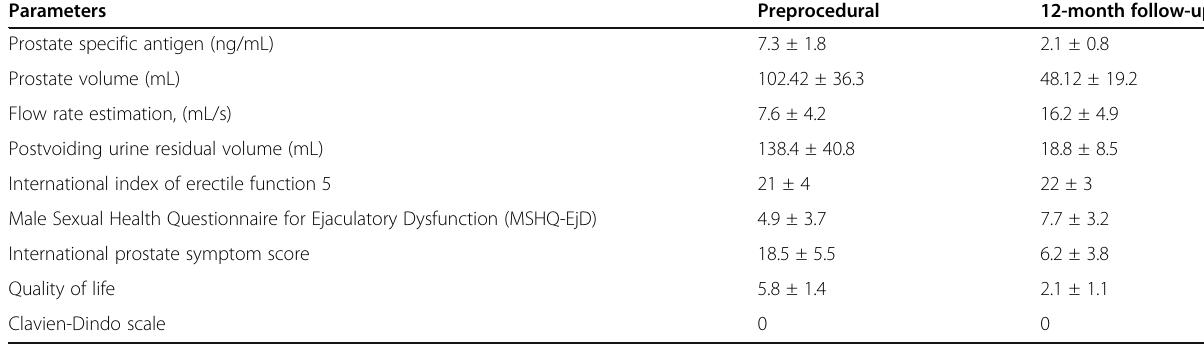
Table 3 Clinical and subjective patient data (preprocedural and at 12-month follow-up)